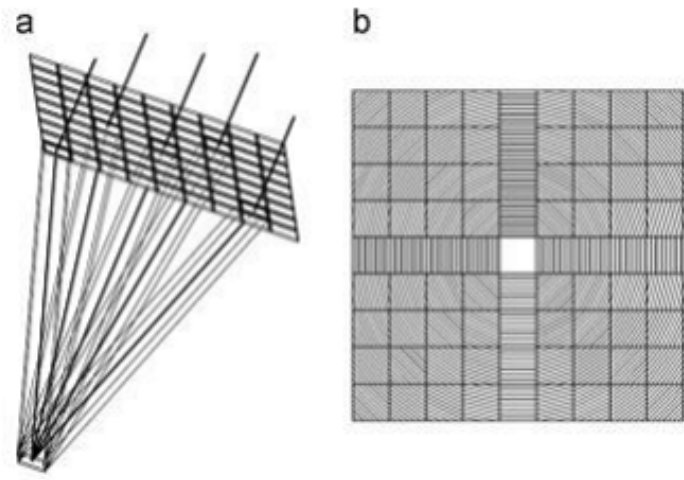
Figure 11. Modular Fresnel lens proposed by Ryu et al. [19]. ( a ) Beam routing and concentration through the modular lens ( b ) Front view of the modular lens. Reprinted from K. Ryu et al., Concept and design of modular Fresnel lenses for concentration solar PV system. Solar energy, 2006 1580–1587, with permission from Elsevier.